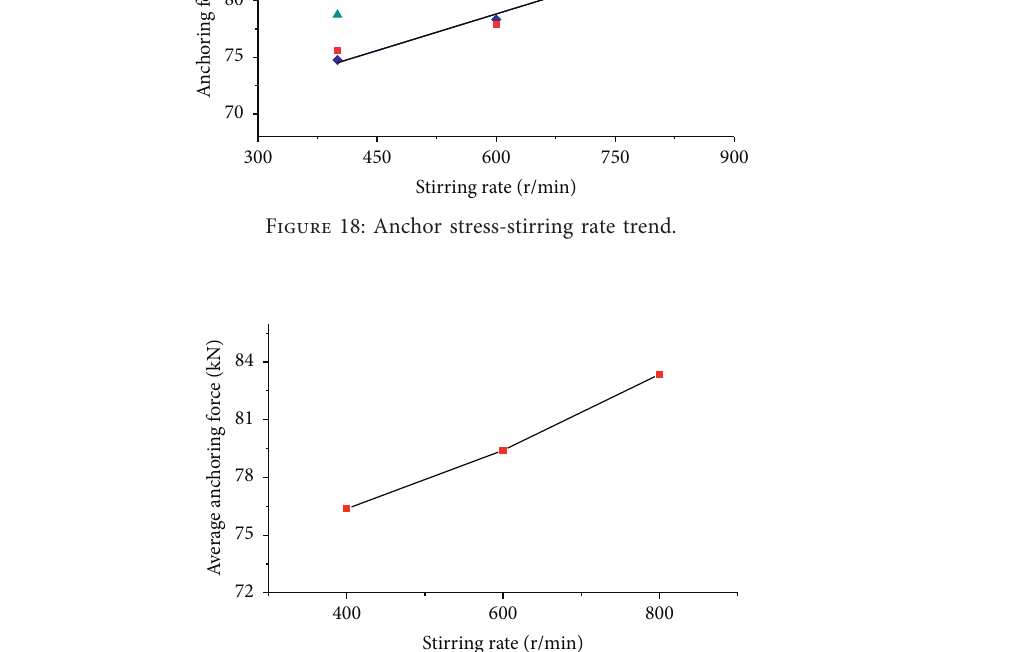
Figure 19: Average anchor stress-stirring rate